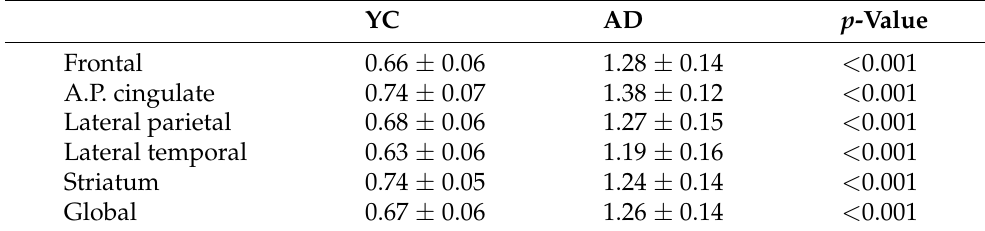
Table 3. Averaged SUVR of the Centiloid dataset with p -value.